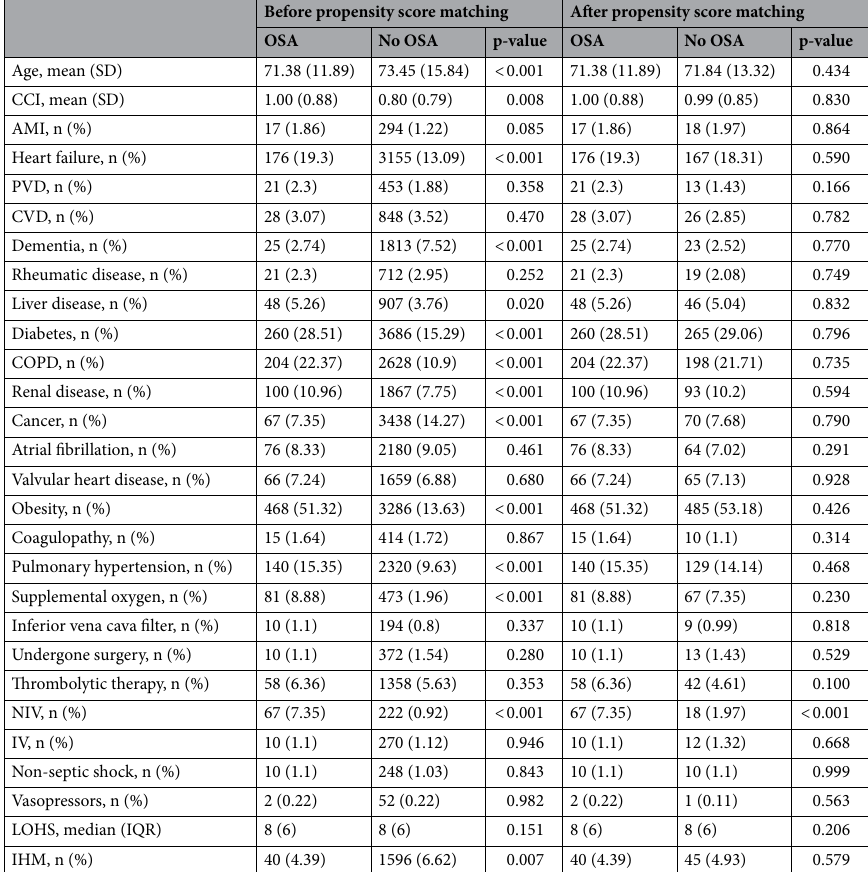
Table 3. Prevalence of specific comorbid conditions. Therapeutic procedures, and hospital outcomes in women hospitalized with pulmonary embolism (PE) according to the presence of obstructive sleep apnea in Spain from 2016 to 2018 before and after propensity score matching. OSA Obstructive sleep apnea, CCI Charlson comorbidity index, AMI acute myocardial infarction. PVD peripheral vascular disease, CVD cerebrovascular disease, COPD chronic obstructive pulmonary disease, NIV non-invasive ventilation, IV invasive ventilation, LOHS length of hospital stay, IHM in-hospital mortality, SD standard deviation, IQR interquartile range. p value for comparison of men and women with